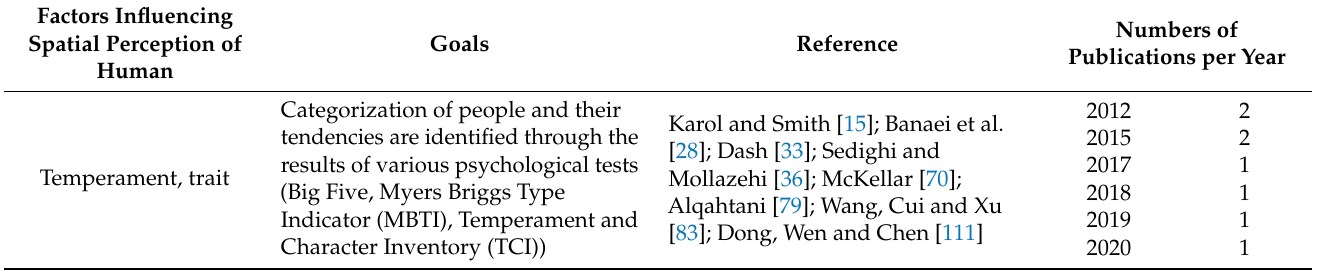
Table 4. Summary of the literature review on human tendencies and behavior in indoor